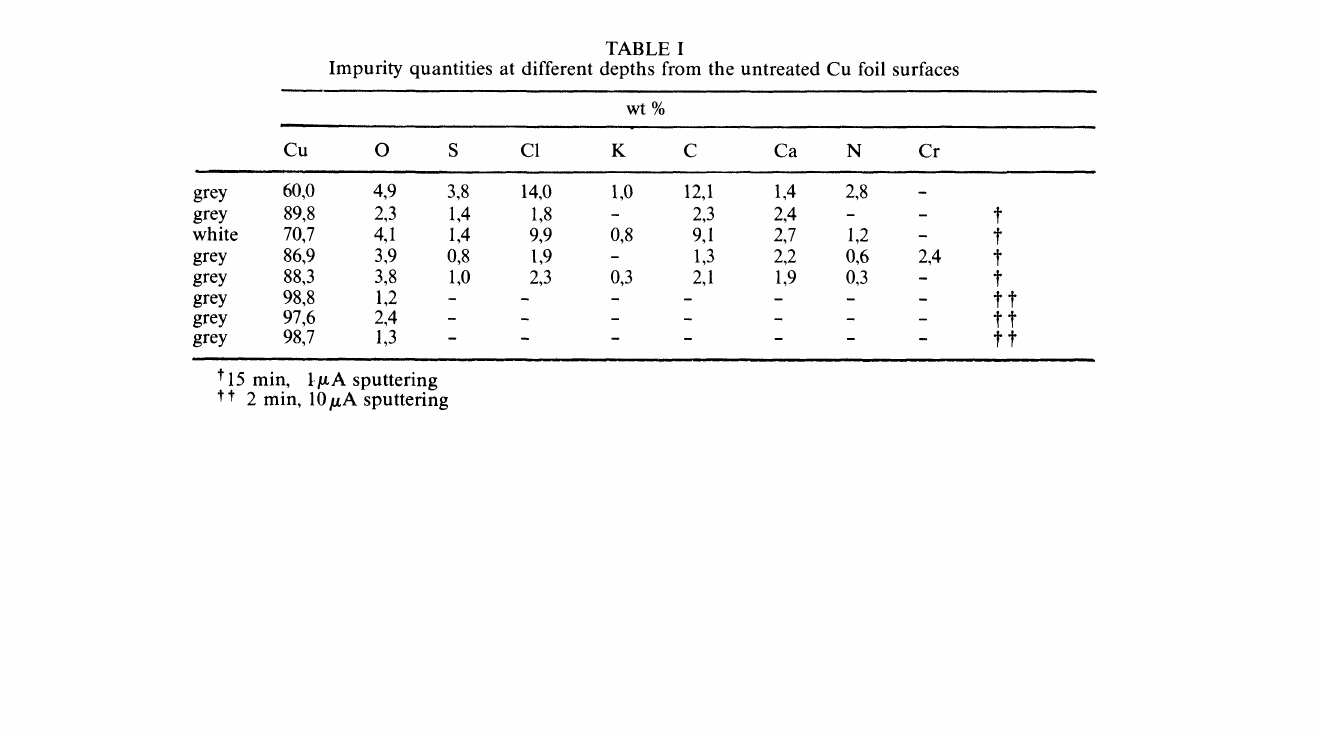
TABLE Impurity quantities at different depths from the untreated Cu foil